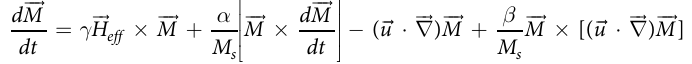
zpin , z in an equilibrium pin